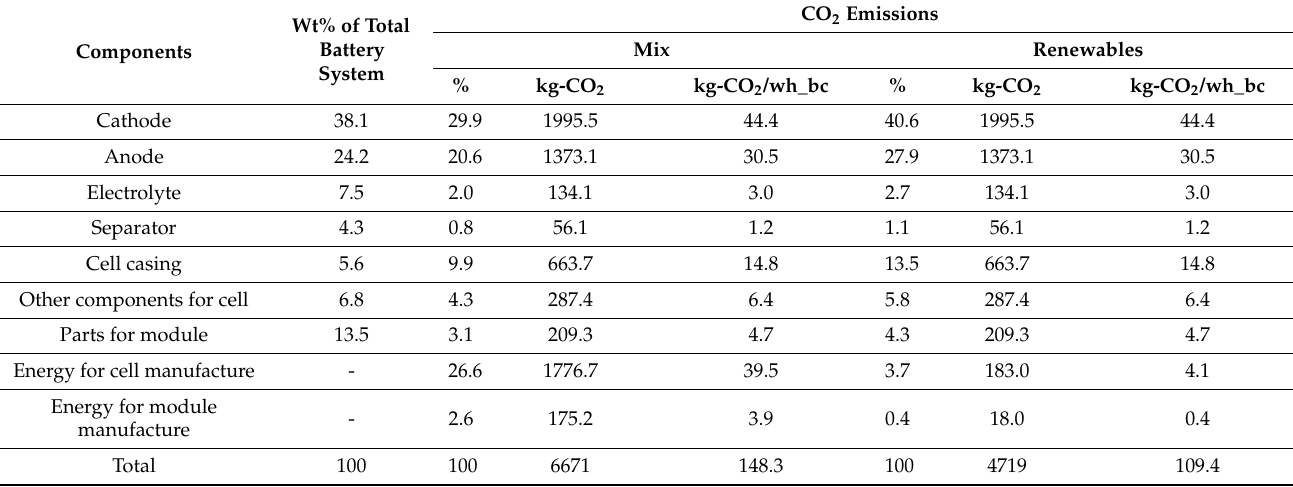
Table 5. CO 2 emissions of material to production